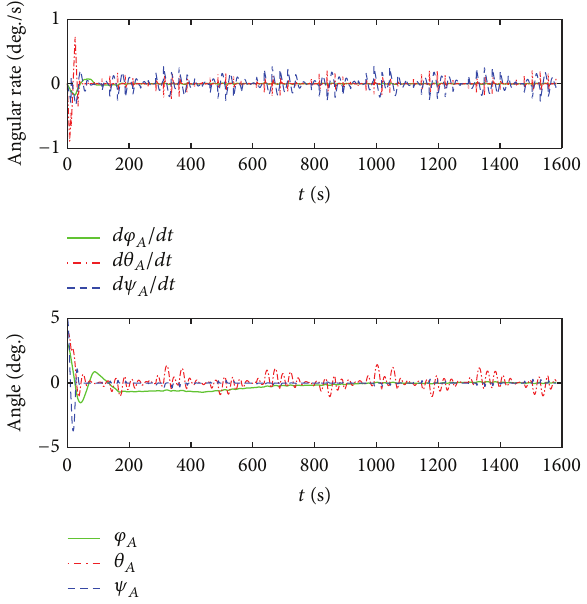
spacecraft will be deeply affected by the librations by observ- ing Figures